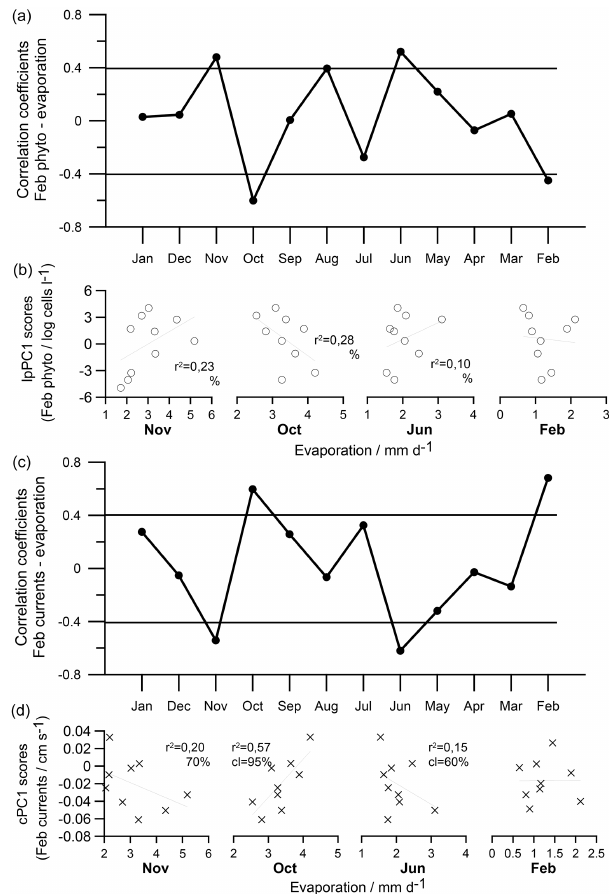
Figure 10. Correlation coefficients and lpPC1 scores of February (log values of phytoplankton; a , b ) and cPC1 (geostrophic cur- rents; c , d ) against monthly averages of evaporation of the previous year during the analysed period (1989–2004) at the Po River delta– Rovinj profile (a, c) . Correlations in November, October, June and February are given graphically (b, d)